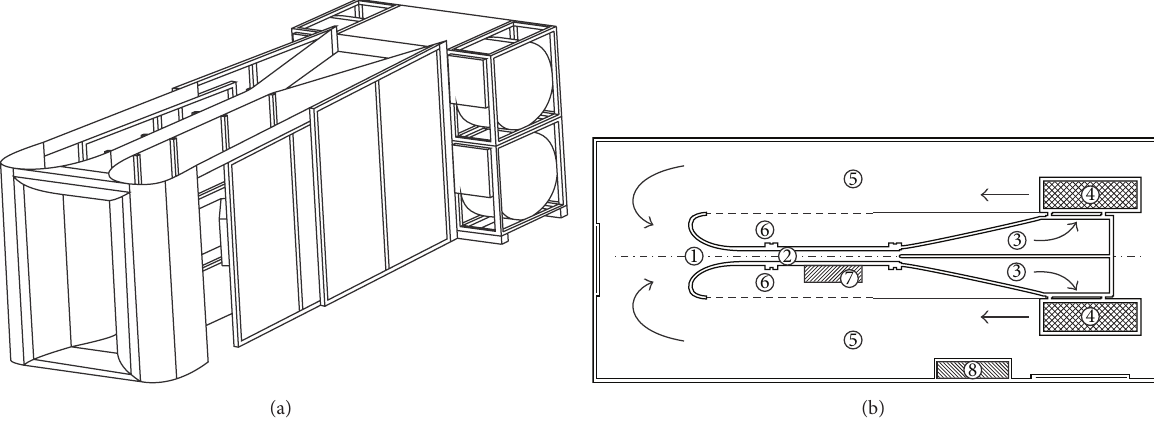
Figure 5: A4C wind tunnel. Isometric view (a) and top view (b): 1—nozzle with two-dimensional contraction, 2—test section, 3—diffuser, 4—centrifugal fans, 5—open flow return, 6—test section access door, 7—instrumentation and technical equipment, and 8—power control